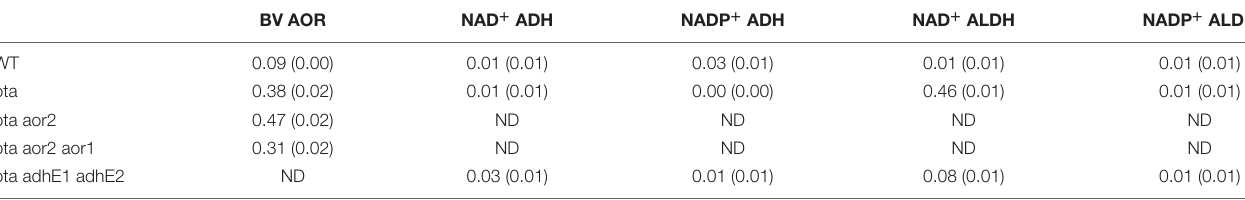
TABLE 1 | AOR, Adh, and Aldh cell free extract specific